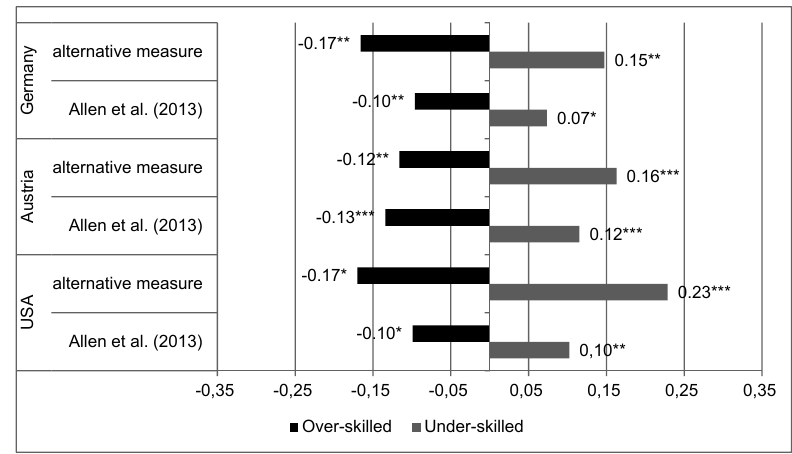
Figure 3 Mincer-regression coefficients of various skill mismatch measures taking all plausible values into